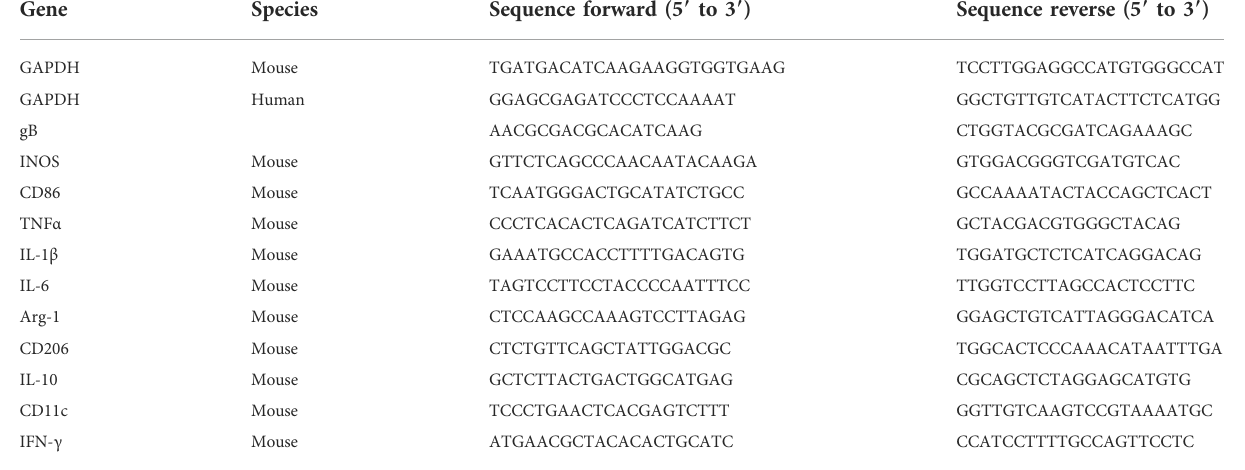
TABLE 1 Primers used for qRT-PCR. Gene